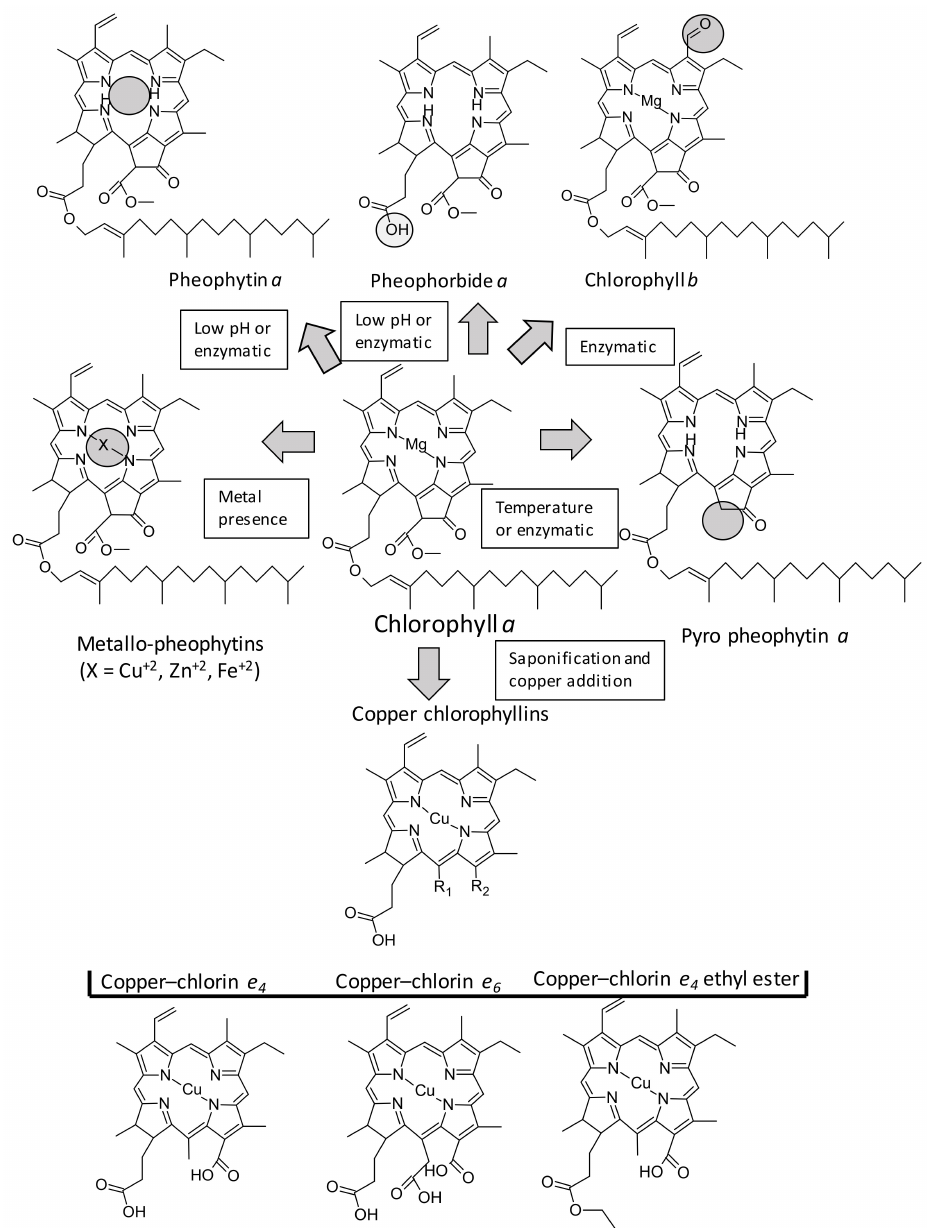
Figure 3. Chlorophyll structures cited in this